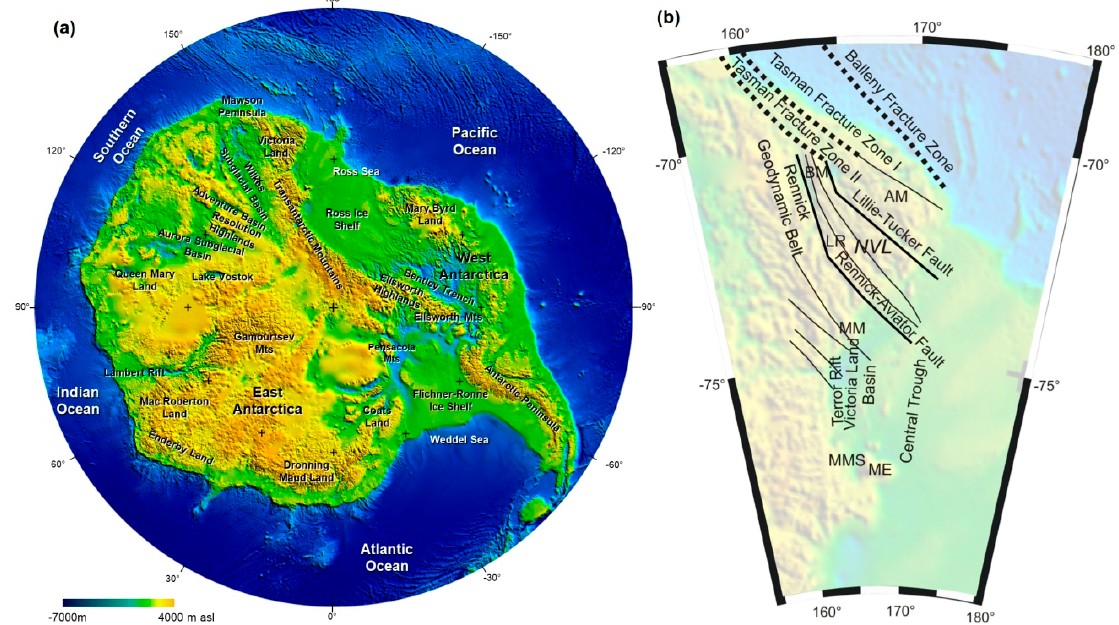
Figure 1. ( a ) Main physiographic features of the Antarctica continent from Bedmap-2 dataset [15] and ( b ) simplified tectonic setting of Victoria Land (VL), modified from [20].